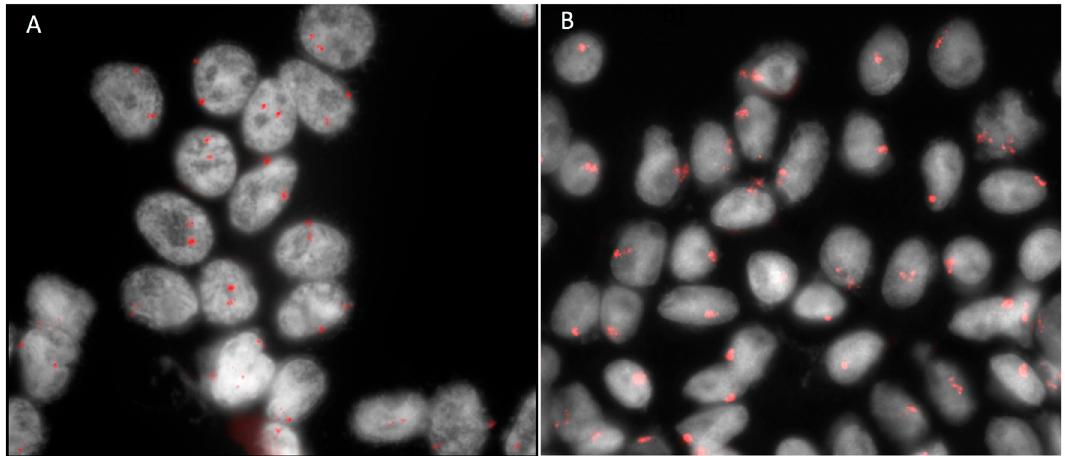
Figure 2. Fluorescence in situ hybridization (FISH) analysis with centromeric probe for chromosome 3 of tumor material obtained by fine needle aspiration biopsy in a case of uveal melanoma. ( A ) Normal cells with two red signals corresponding to two chromosomes 3. ( B ) Monosomy 3: cells with one red signal have lost one chromosome 3 .